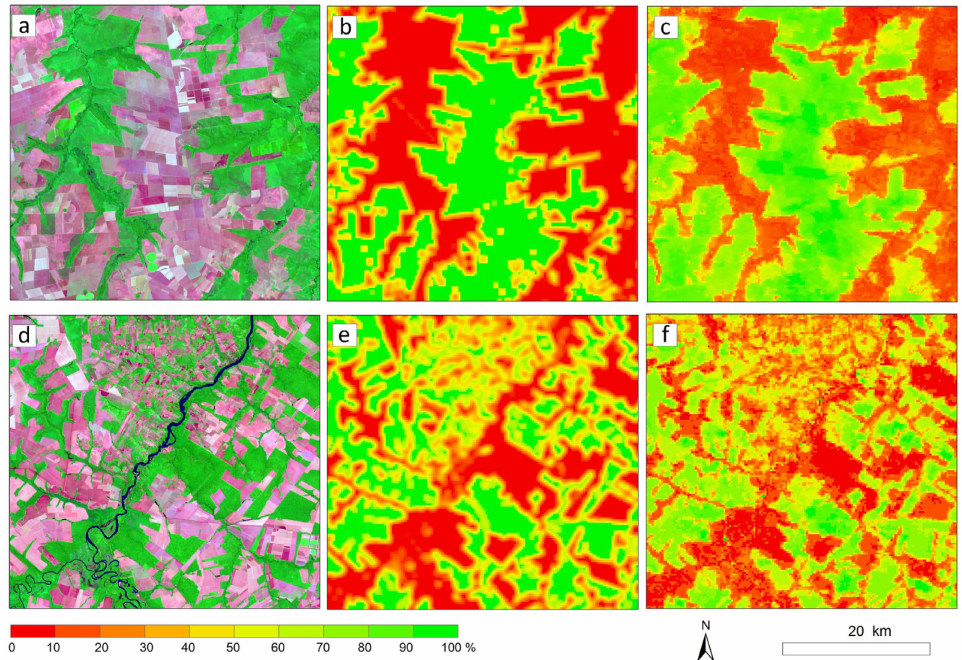
Figure 7. A comparison of fractional cropland distributions between Landsat-derived reference data and the SDI-based estimates (note: ( a – c ) represent Landsat TM color composite (7/4/2 bands), fractional cropland distribution from Landsat imagery, and fractional cropland distribution from MODIS EVI data at typical site 1, respectively; ( d – f ) represent Landsat TM 7/4/2 band color composite, fractional cropland distribution from Landsat imagery, and fractional cropland distribution from MODIS EVI data at typical site 2, respectively).